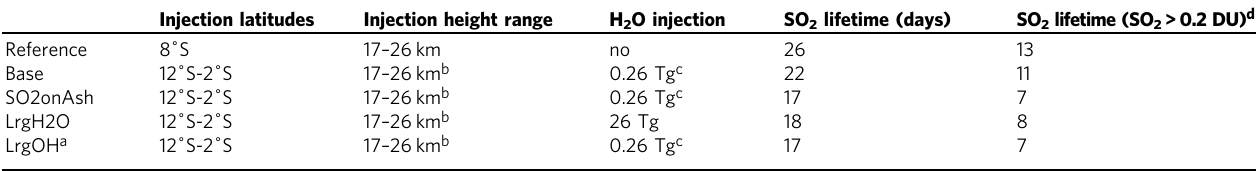
Table 1 The model cases and the parameters related to SO 2 injection, as well as the SO 2 lifetime of each case. Injection